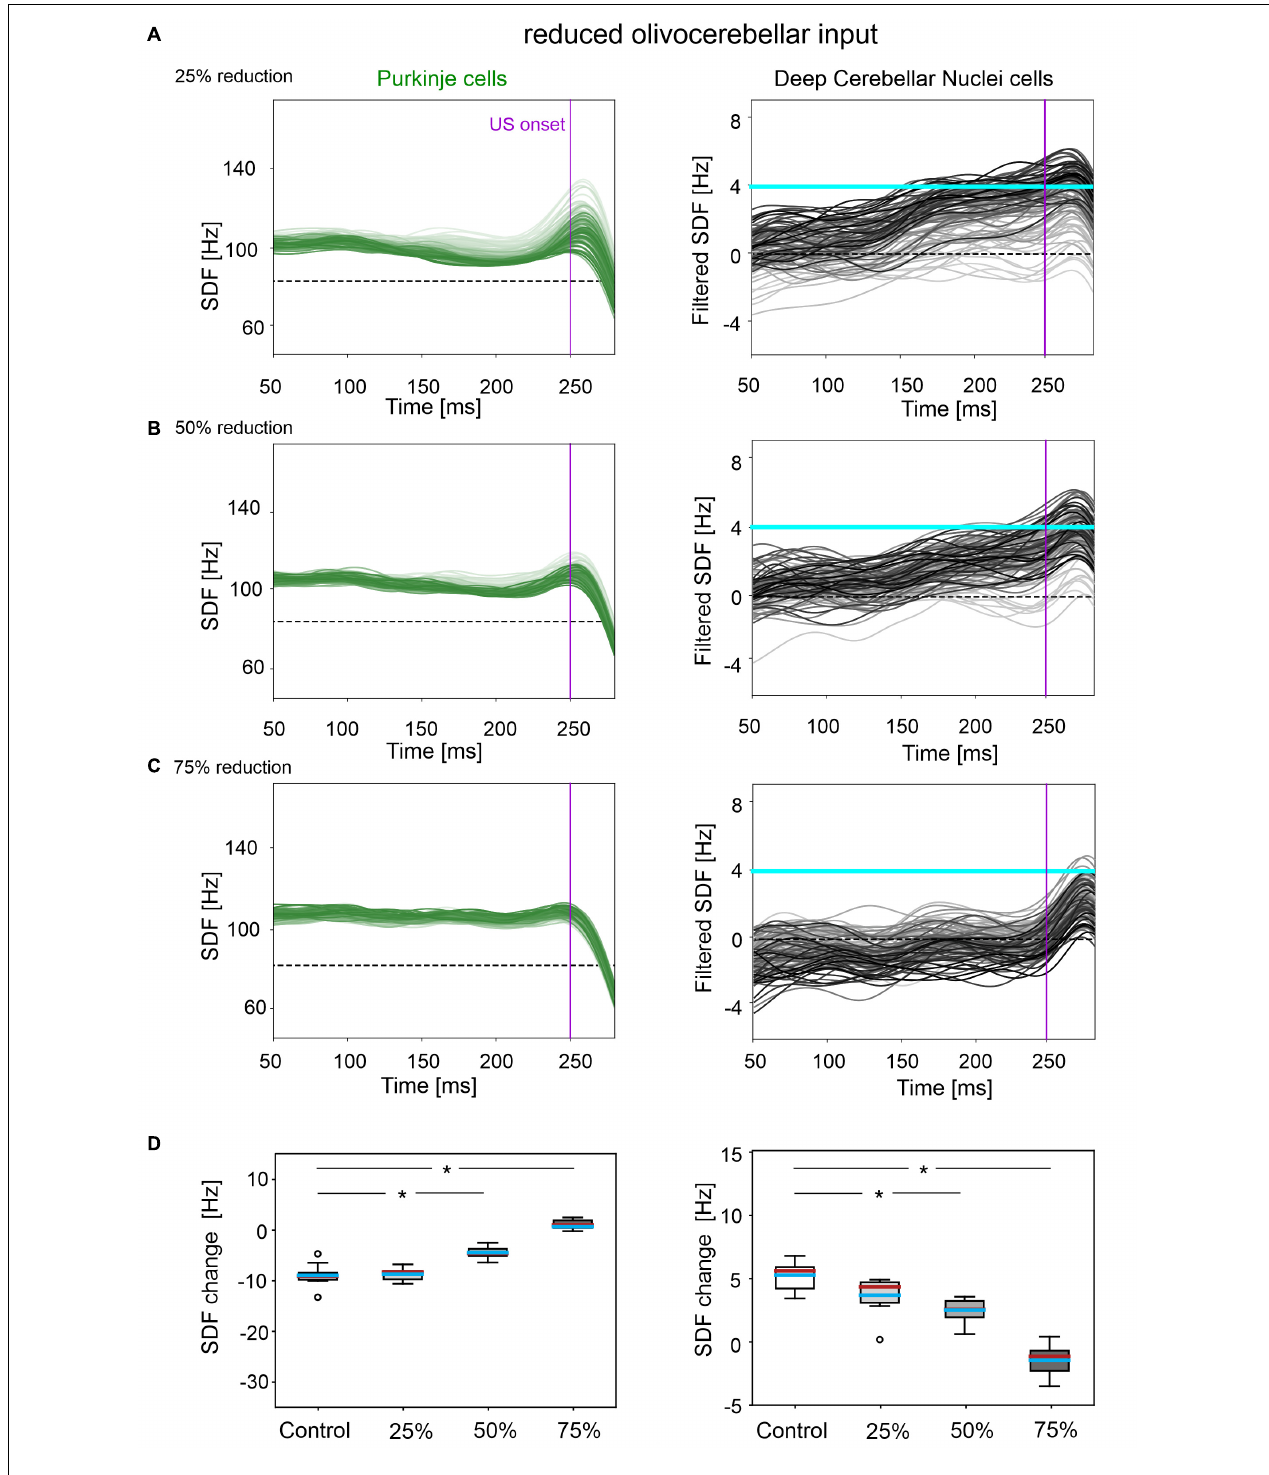
FIGURE 3 | Neural activity underlying EBCC in the case of reduced olivocerebellar input by 25% (A) , 50% (B) , 75% (C) . SDF in PC population and DCN motor output (averaging across cell SDFs) for each trial (0 ms is aligned with the CS onset). Increasing darkness of the lines corresponds to subsequent trials (the lightest is the first trial, the darkest is the last trial). Dashed horizontal line indicates baseline activity, solid horizontal cyan line (right panels) represents CR threshold. Purple vertical line corresponds to US onset time. (D) SDF change in PC (left) and DCN (right) populations from the 10 trials in the last block, with respect to SDF value in the first 100 ms from CS onset. Cyan horizontal line indicates the mean, red horizontal line the median, box edges the 1st and 3rd quartile, whiskers the minimum and maximum accepted values, excluding outliers (indicated as circles). * corresponds to p < 0.01 in the Wilcoxon test.